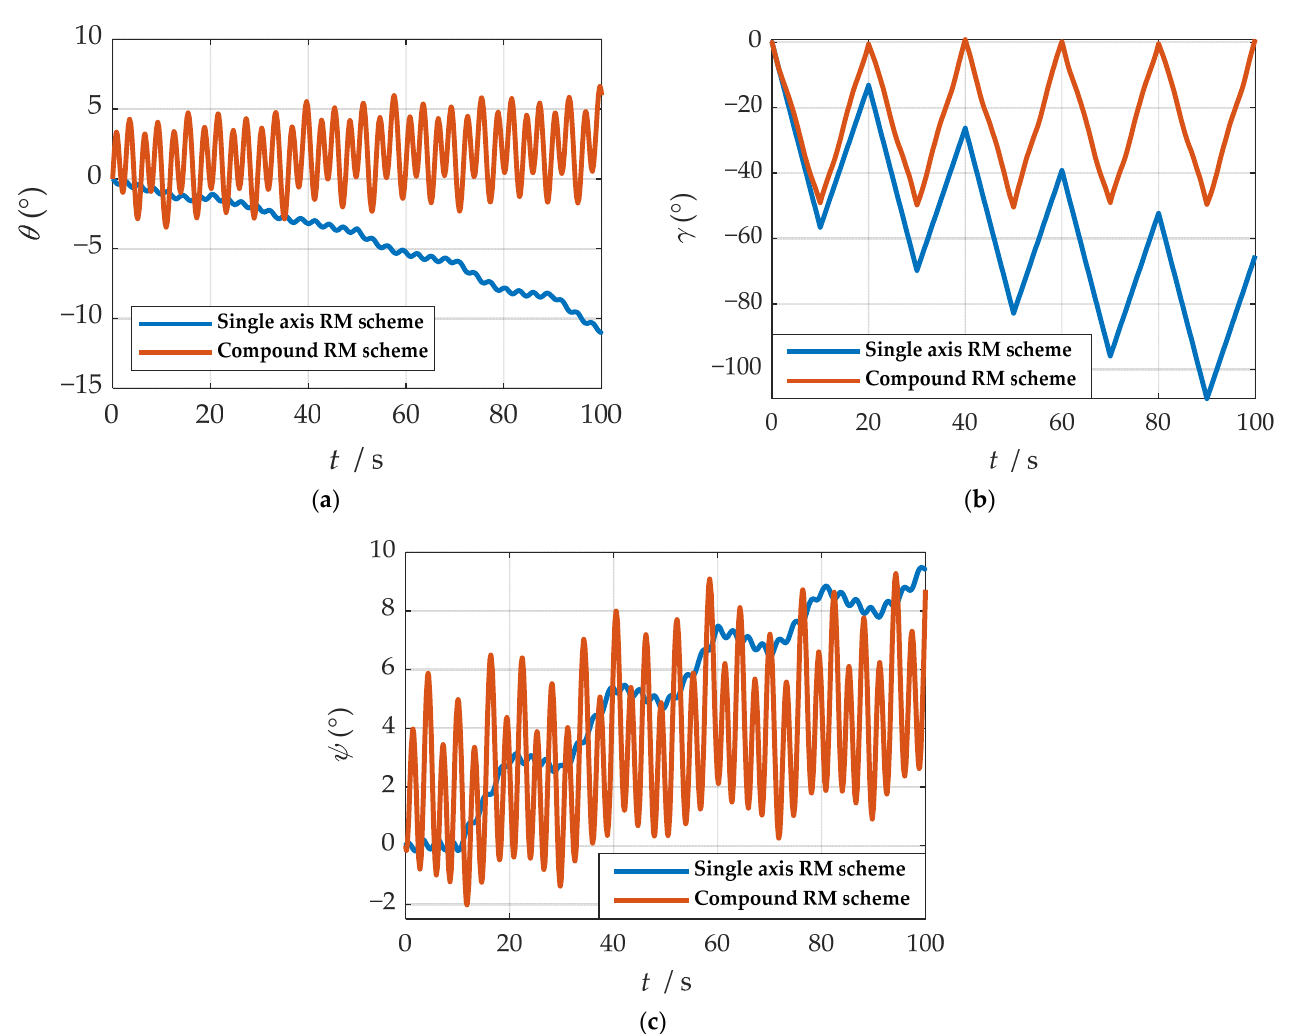
Figure 27. Comparison of attitude solution results: ( a ) comparison of calculation results of yaw angle; ( b ) comparison of calculation results of roll angle; ( c ) comparison of calculation results of pitch angle. Table 11. Maximum errors between two rotational modulation schemes comparison.